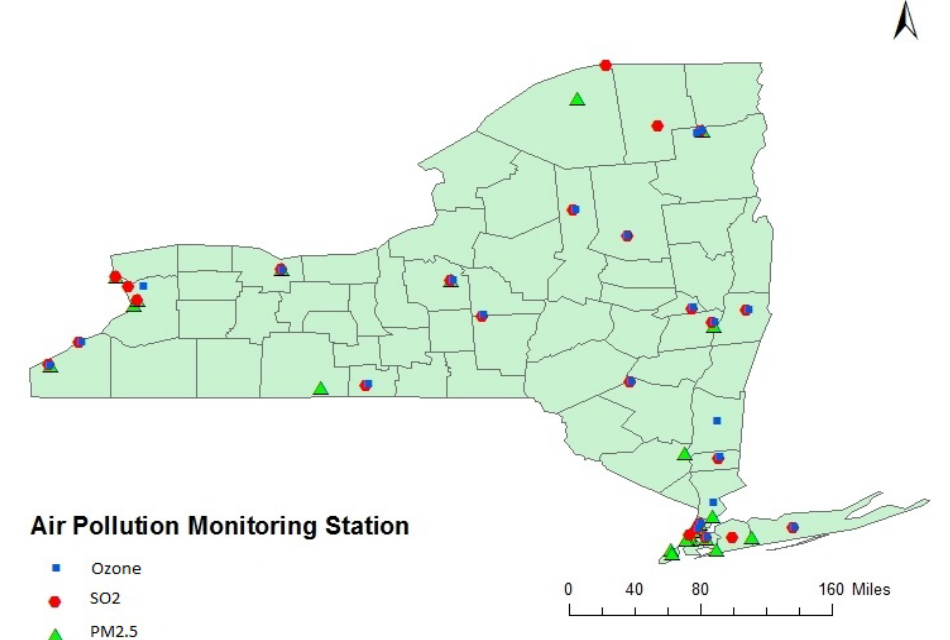
Figure 4. Air Pollution Monitoring Station in New York